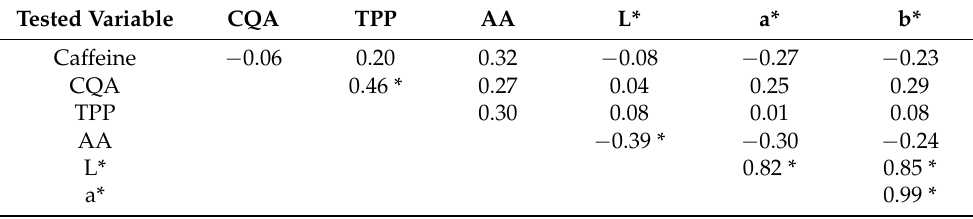
Table 5. Relationships between tested chemical markers: caffeine, chlorogenic acid (CQA), total polyphenols (TPP) and acrylamide (AA), and colour coordinates: L* (lightness), a* (colour space between red and green) and b* (colour space between yellow and blue); correlation coefficients, n = 16. Tested